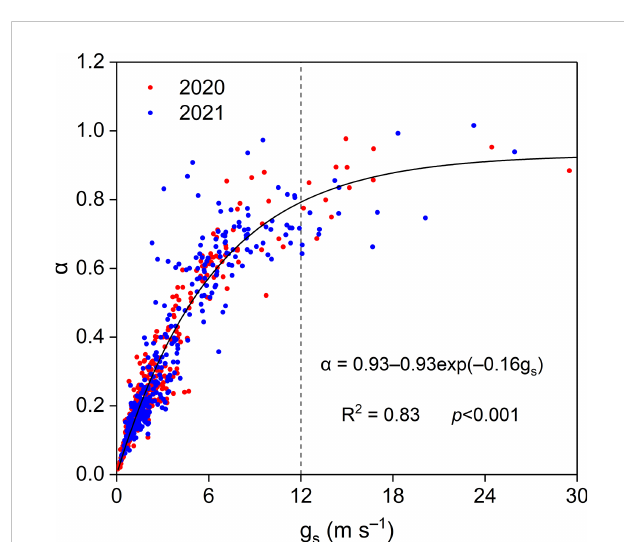
FIGURE 12 Relationship between midday a and g s in the Pinus tabuliformis plantation.